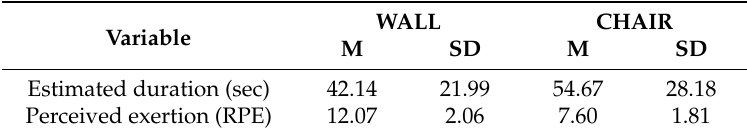
Table 1. Means and Standard Deviations of Estimated Duration and Perceived Exertion for the WALL and CHAIR Conditions in Experiment 2.